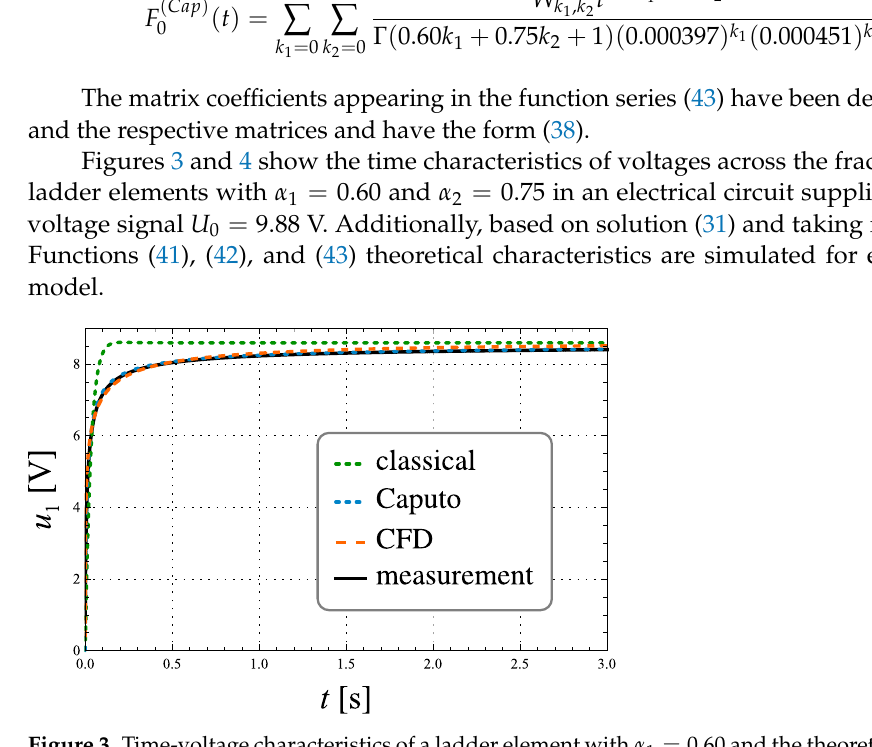
Figure 3. Time-voltage characteristics of a ladder element with α 1 = 0.60 and the theoretical responses of the models.